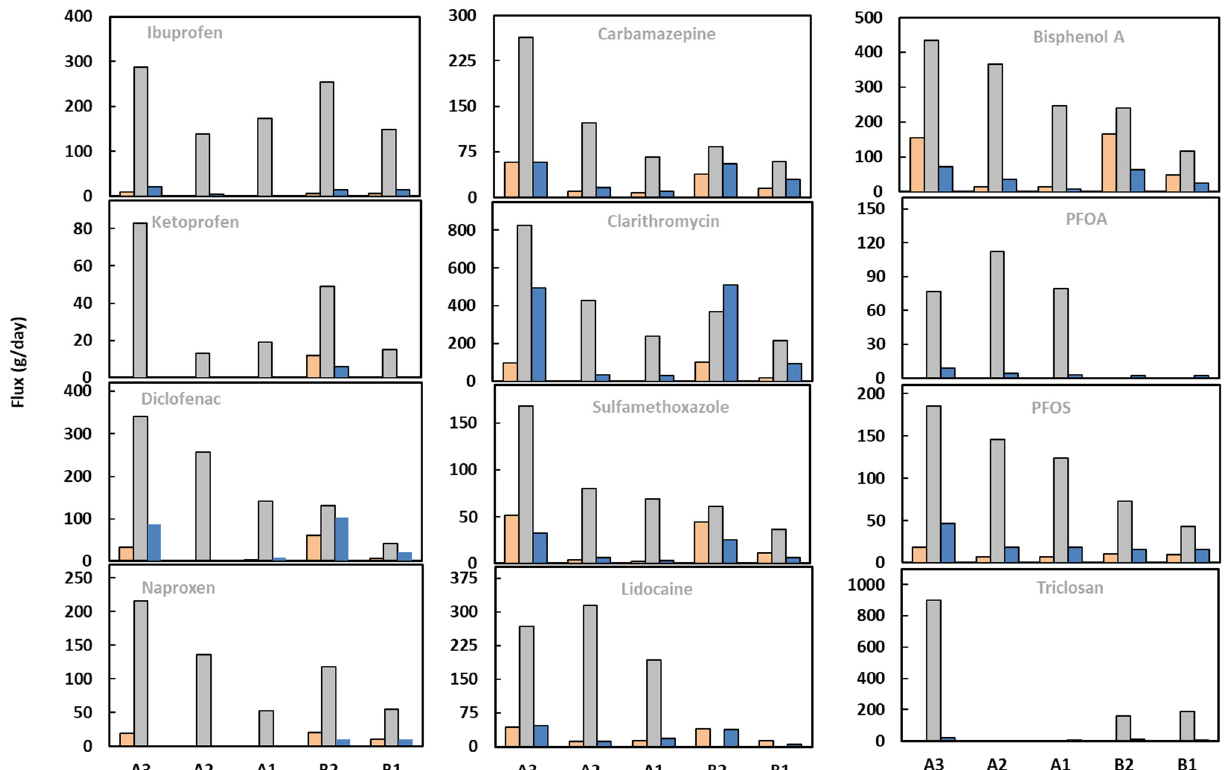
Figure 4. Mass flux (g/day) of each of the quantified micropollutants at different sites in the three sampling periods. The orange bars (left) correspond to September, the grey bars (middle) to January, and the blue bars (right) to October.